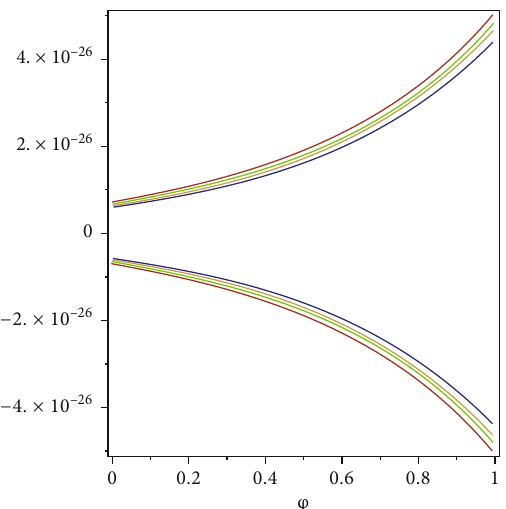
Figure 8: The two-dimensional fuzzy lower and upper branch graph of the di ff erent fractional-order of ϱ